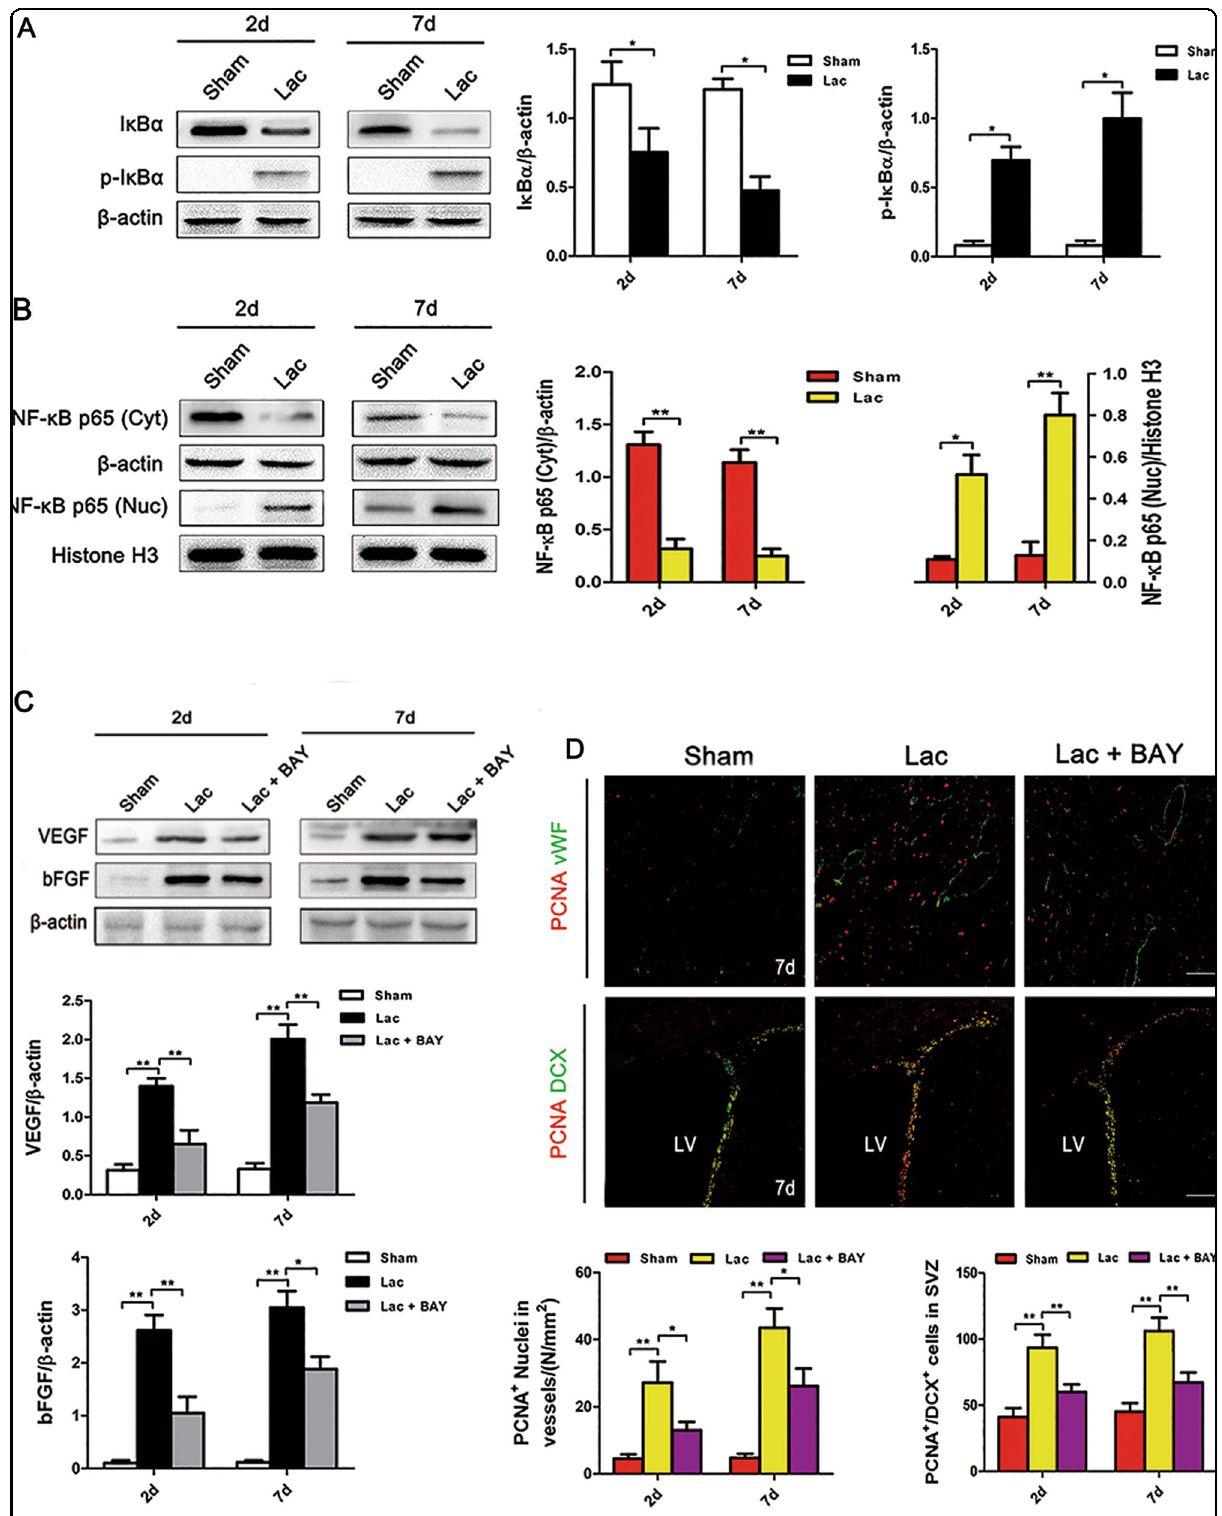
Fig. 5 a , b I κ B α was degradated and phosphorylated after L -lactate infusion, and NF- κ B p65 protein translocated into the nucleus. c The expression levels of VEGF and bFGF were strikingly increased after L -lactate infusion. BAY blocked these effects. d L -lactate signi fi cantly increased the expression of PCNA + /vWF + nuclei and PCNA + /DCX + cells. BAY blocked these effects. Lac L -lactate, BAY BAY11-7082. * p < 0.05 and ** p < 0.01. n = 5. Scale bar = 100 μ